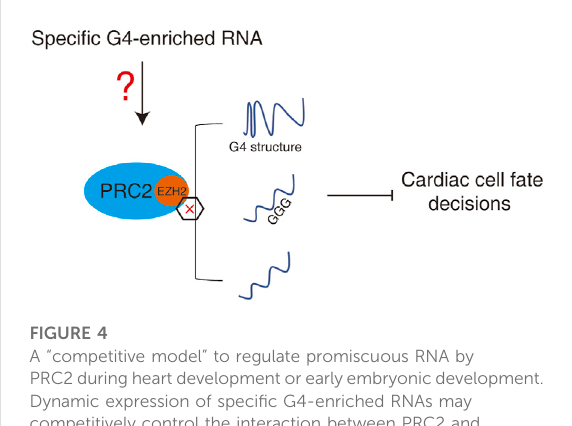
FIGURE 4 A “ competitive model ” to regulate promiscuous RNA by PRC2 during heart development or early embryonic development. Dynamic expression of speci fi c G4-enriched RNAs may competitively control the interaction between PRC2 and other RNAs, and therefore control the promiscuous RNAs- mediated PRC2-dependent epigenetic